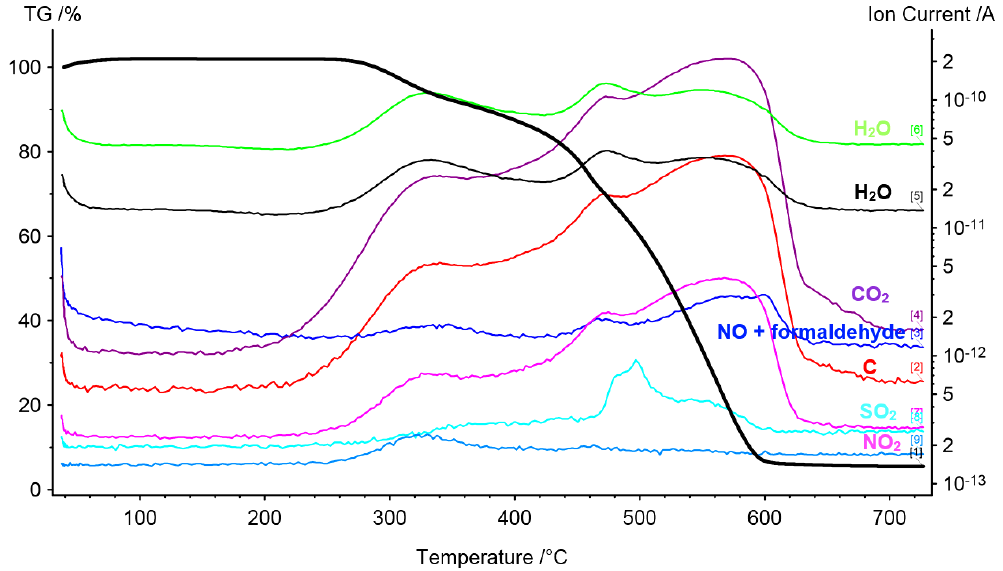
Figure 8. TGA-MS analysis of the Jerusalem artichoke combustion process.